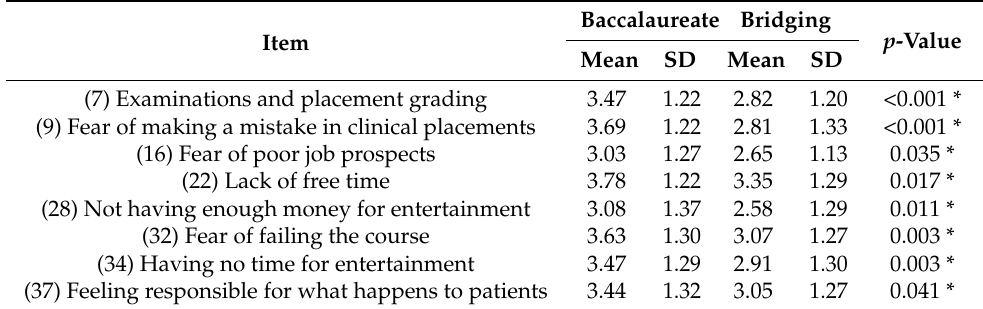
Table 4. Levels of stress by SINS questionnaire item among baccalaureate versus bridging nursing students (independent t